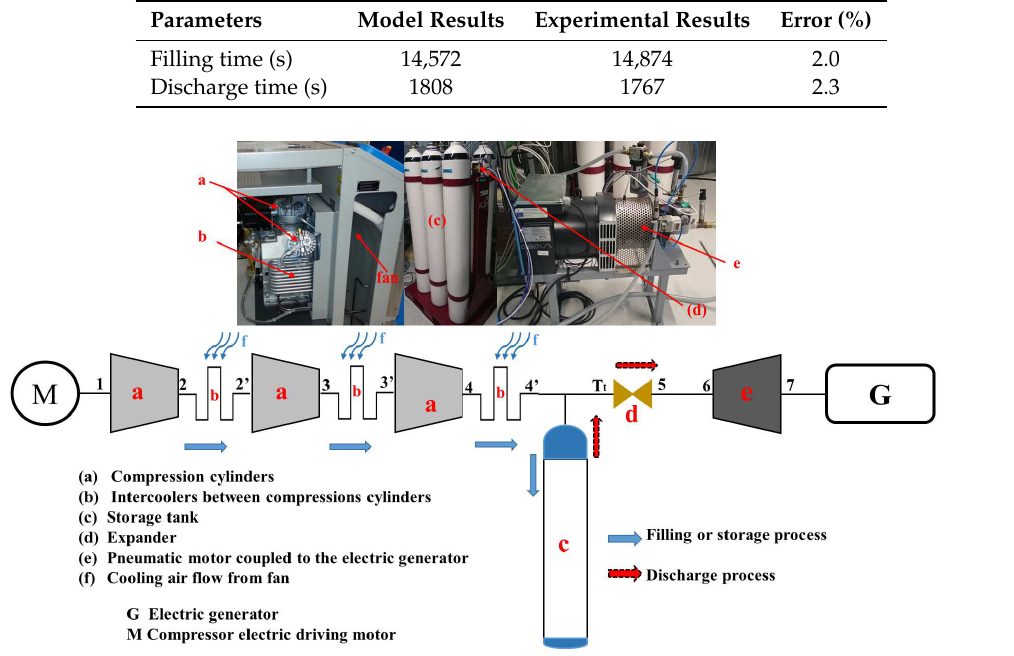
Table 3. Comparison between model results and experimental results of filling and discharge time of storage tank.